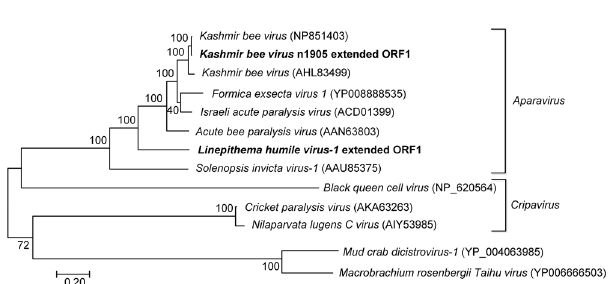
Figure 3. Organization of Linepithema humile virus-1 LHUV-1 partial genome. The total nucleotide sequence length that was recovered from our analysis is indicated on the left of the figure. The light grey box indicates the predicted open reading frame (ORF1) of 1930 amino acids. Darker grey boxes identify protein motifs and their position within the ORF. The jagged grey box indicates the partially recovered ORF2, which contained a sequence that matched Dicistroviridae capsid proteins. Identifiable conserved ssRNA virus protein domains in ORF1 (Hel = helicase [position 549–664], Pro = Protease [position 1153–1381], RdRp = RNA-dependent RNA polymerase [position 1433–1927]) are indicated.